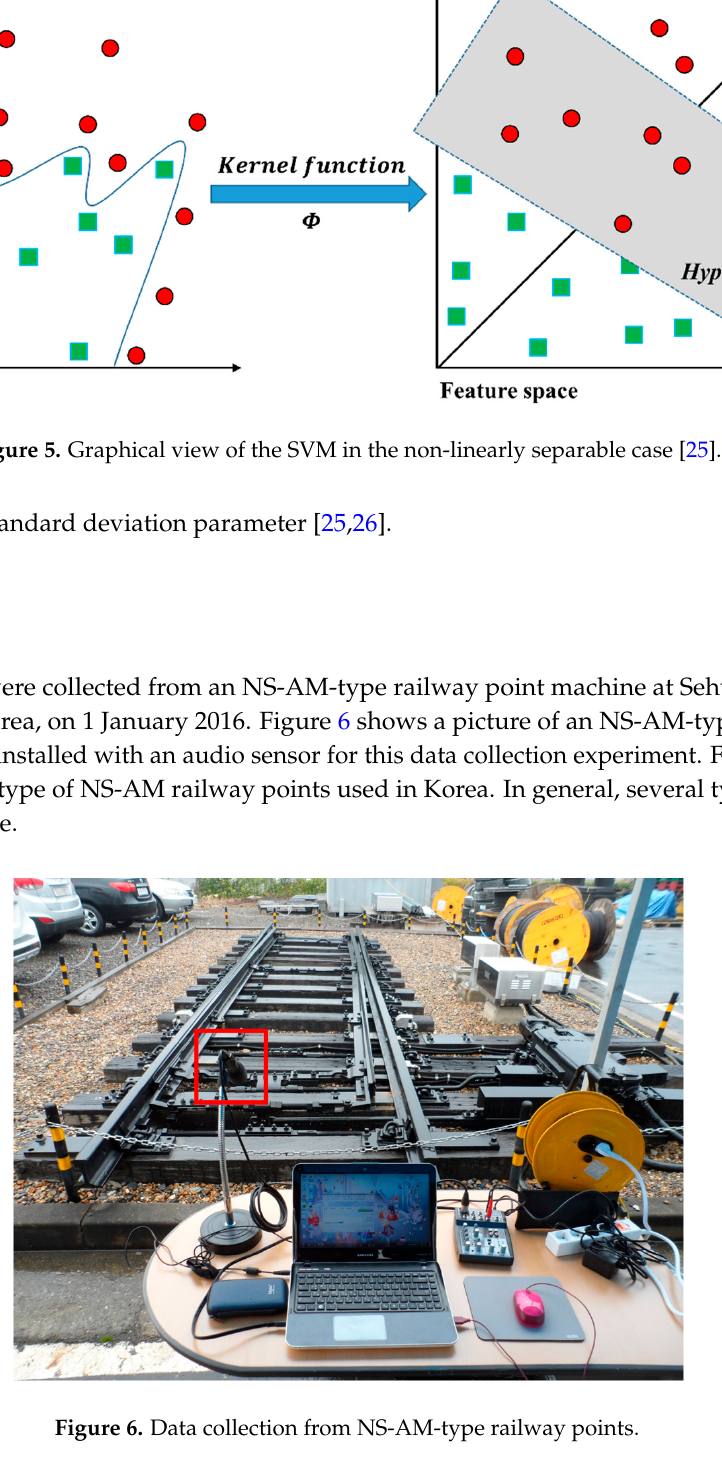
Figure 7. Schematic for NS-AM-type railway points [1]. Figure 8 shows a fishbone diagram for point failure [7]. As shown in Figure 8, we collected audio data while simulating three fault conditions that include normal data: “ice obstruction”, “ballast